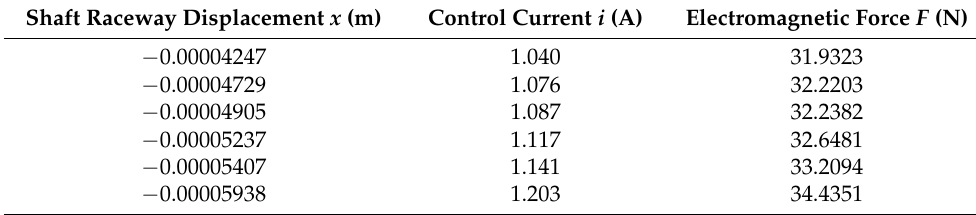
Table 4. Measured parameters of the